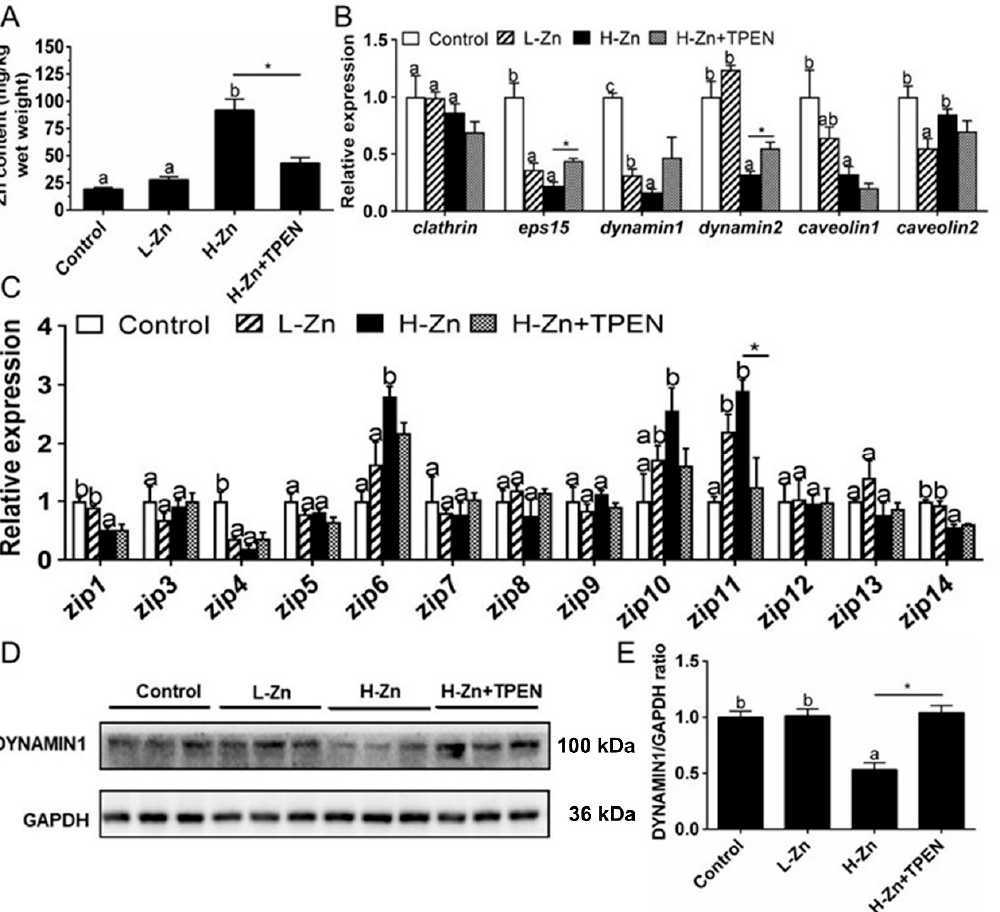
Figure 1. Zn accumulation and transport in the intestines of yellow catfish fed four experimental diets. ( A ) Zn content. ( B ) The mRNA expression of endocytosis genes. ( C ) The mRNA levels of Zn transporters. ( D ) Protein levels of Dynamin1. ( E ) Quantification of Dynamin1 protein level. Values are means ± SEMs, n = 3. L-Zn: low dietary Zn; H-Zn: high dietary Zn; H-Zn + TPEN: high dietary Zn + TPEN; Different letters indicate significant differences among three dietary Zn levels ( p < 0.05). Asterisks (*) indicate significant differences between 100 mg/kg nano-ZnO and the 100 mg/kg nano-ZnO + TPEN group ( p <